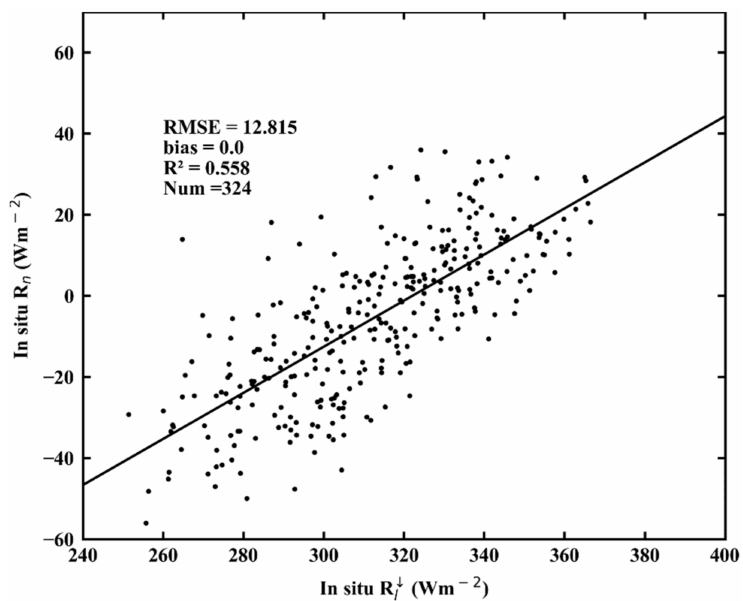
Figure 6. Scatter plot showing relationship between the in situ daily ocean surface R n and R ↓